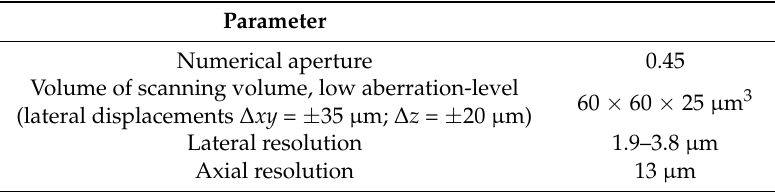
Table 1. Expected optical performances of glass-ball microscanner.